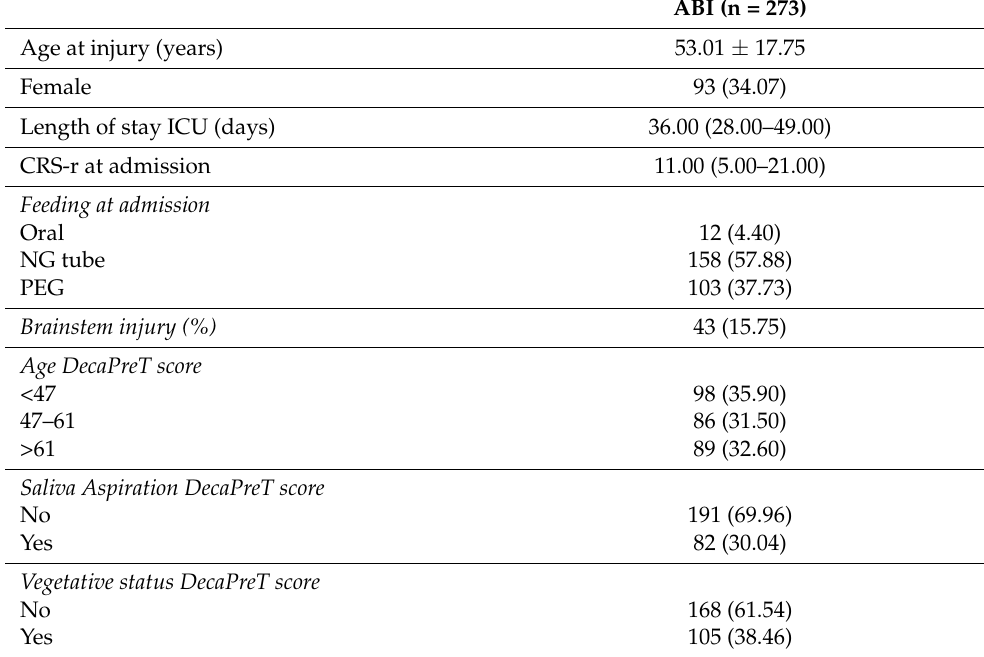
Table 1. Clinical characteristics of the study cohort. Data are presented as mean ± SD for normally distributed continuous variables, median (IQR) for nonnormal distributed continuous variables, or count (%) for categorical